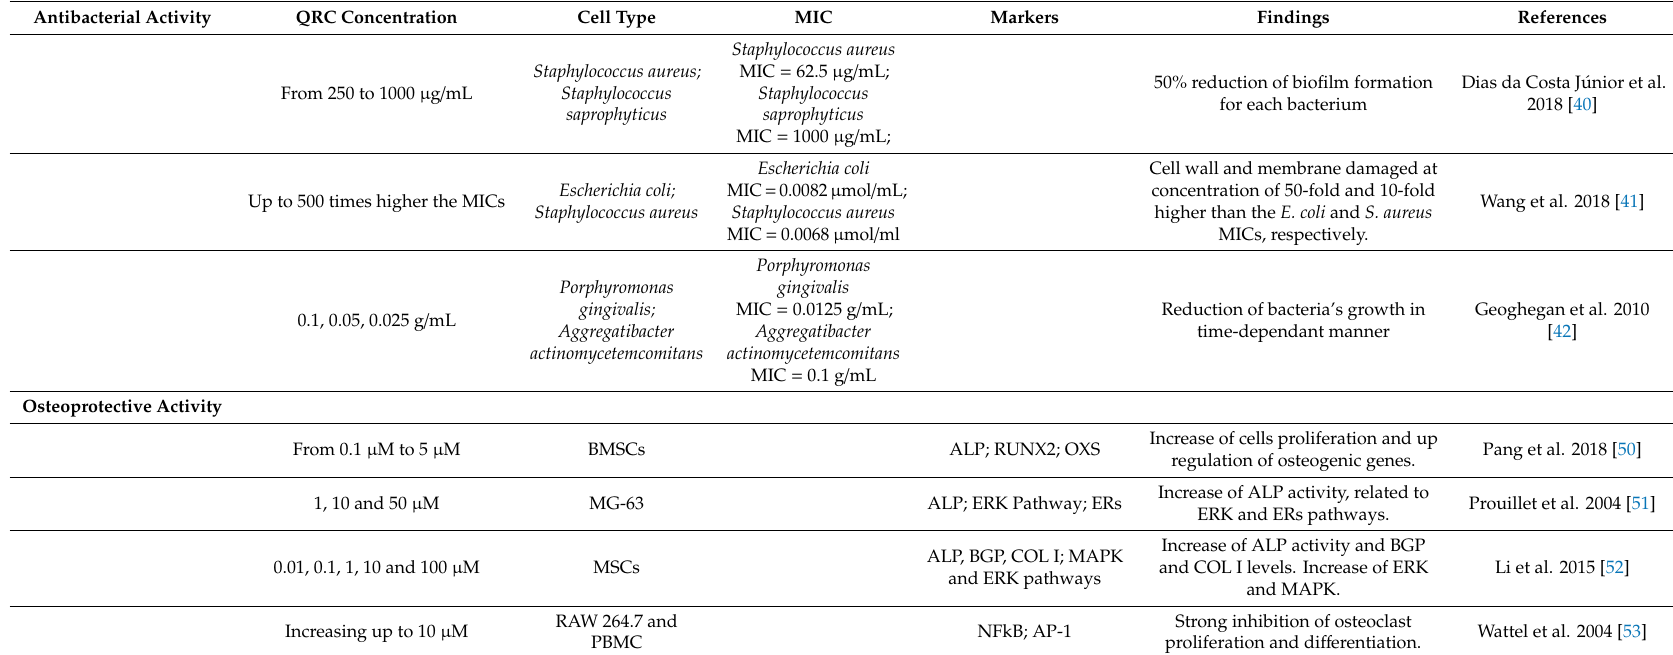
Table 1. Summary of in vitro QRC antibacterial activity and bone tissue regeneration